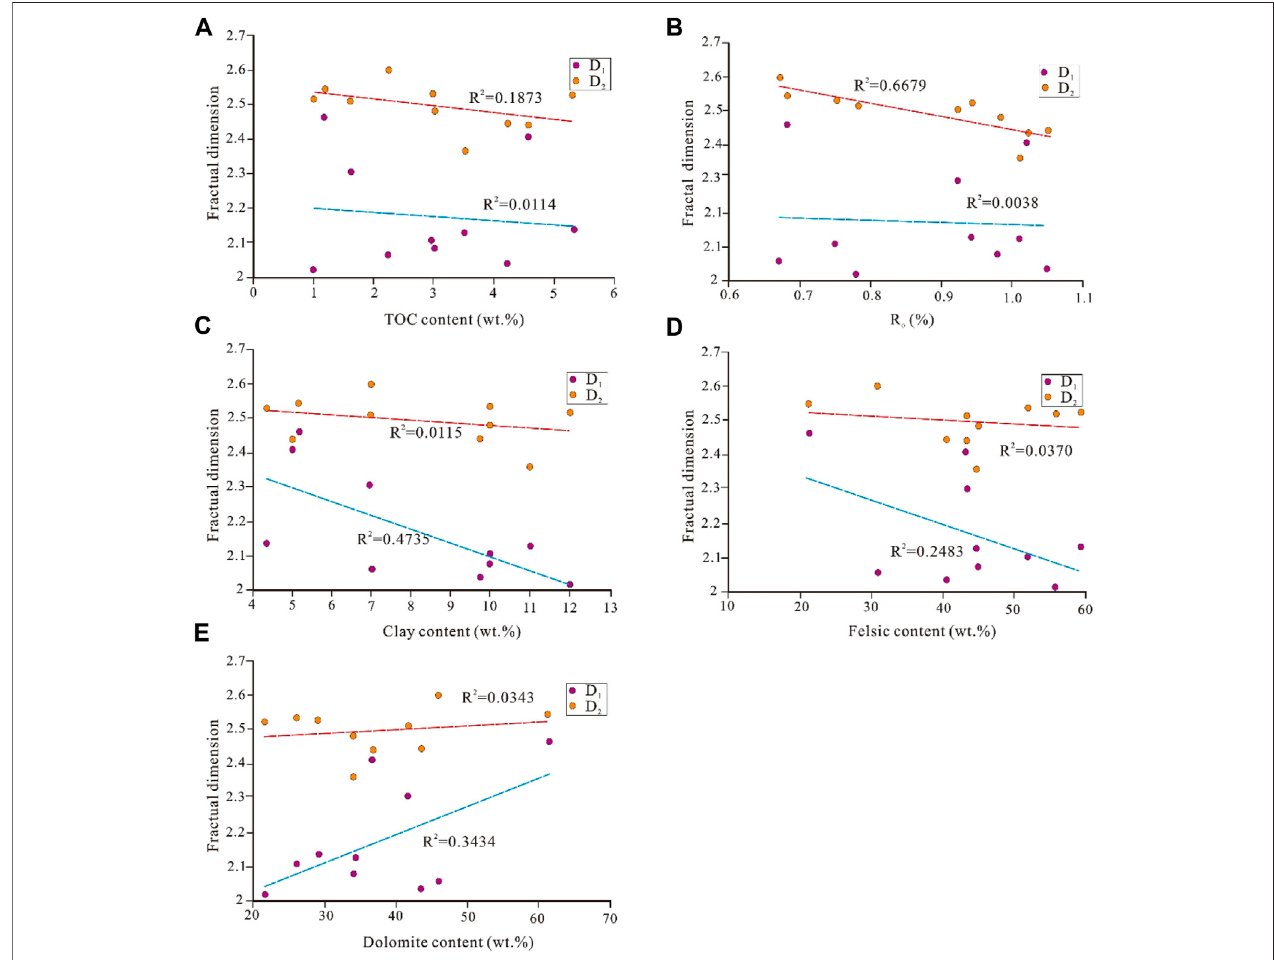
FIGURE 12 | The scatter diagrams and correlations of fractal dimensions vs mineral compositions, TOC content, and R o .